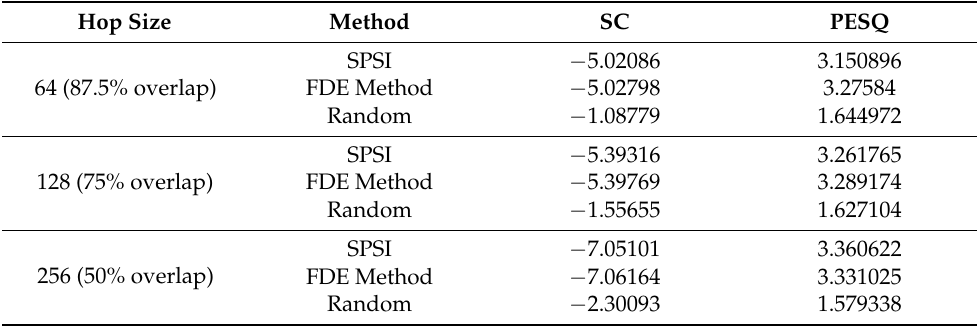
Table 1. Mean SC and PESQ measurement results of SPSI, FDE method, and random phase concern- ing increasing hop